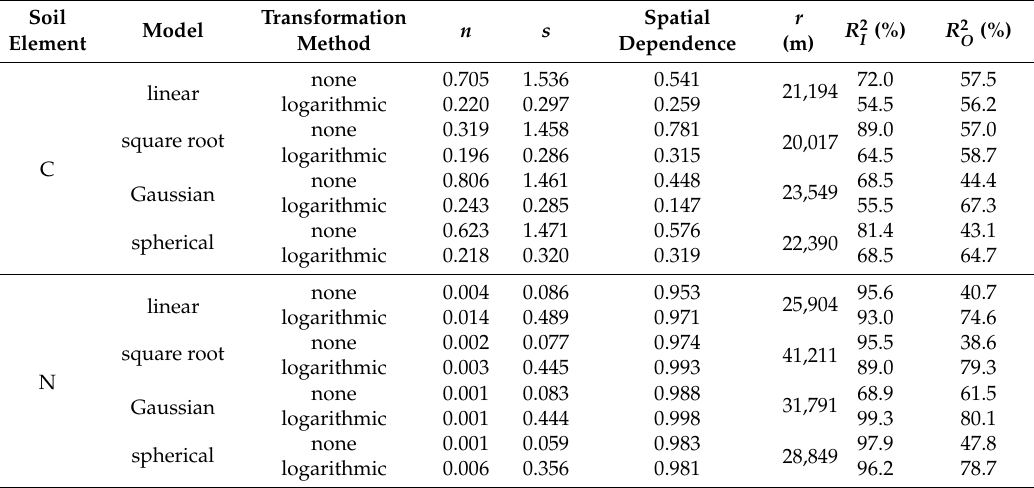
Table 4. Statistical properties of interpolation results for 20–30 cm soil